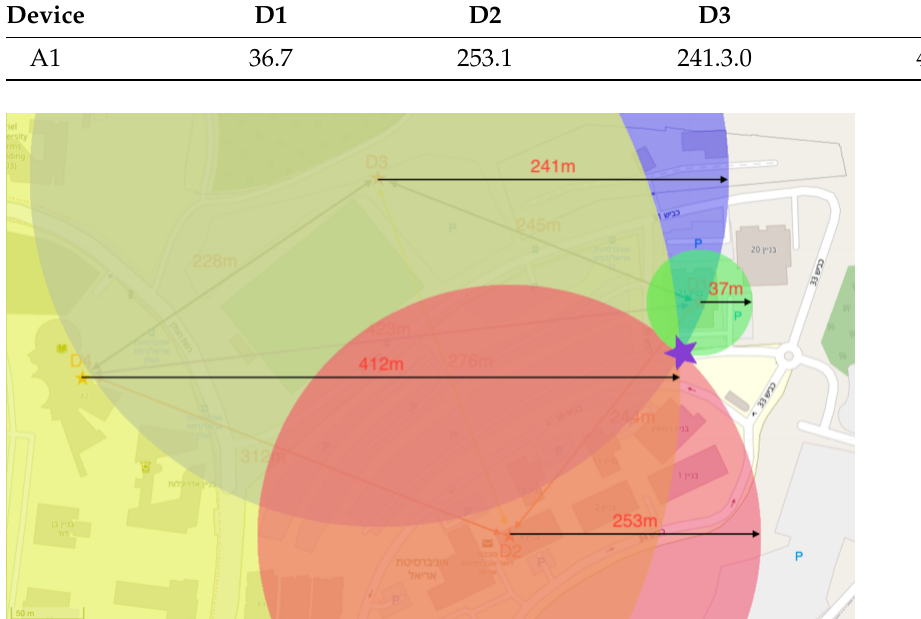
Figure 11. The node found its relative position using the wireless sensor network